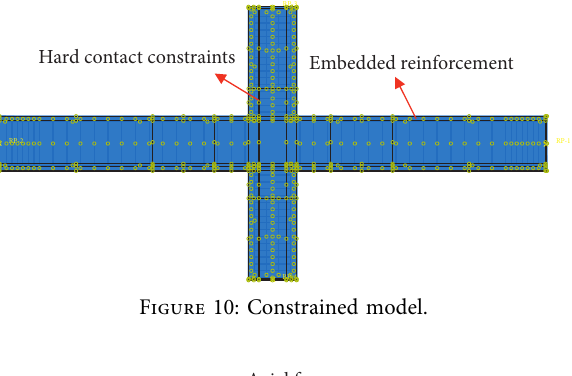
Figure 10: Constrained